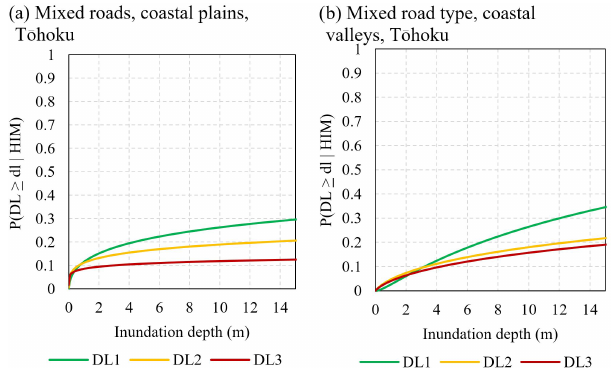
Figure 19. Fragility functions for roads on coastal plains (a) and coastal valleys (b) for the 2011 T ¯ ohoku earthquake and tsunami,